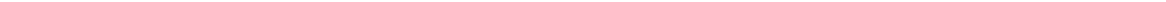
Fig. 4 Nkx2.5 expression in emu wing skeletal muscle. In situ hybridization analysis of muscle markers in the emu wing ( a ) Nkx2.5 , HH30 ( b ) Pax3 , HH30 ( c ) Stc2 , HH30 ( n = 2 at each stage). Note that expression of Nkx2.5 is restricted to the wing muscle precursors ( black arrowheads in a – c ) and latissimus dorsi ( red arrowheads ) but is not present in axial muscle precursors ( arrows in b ). d Real-time RT-PCR analysis of Nkx2.5 expression in embryonic and adult tissues demonstrating strong expression in the forelimb bud and Triceps brachii (mean ± SD). Histological sections illustrating muscle morphology in ( e , f ) Rectus femoris and ( g , h ) Triceps brachii. Inset , overview of the Rectus femoris (Rf) and Triceps brachii (Tb) at the same magni fi cation, illustrating the relative sizes of the two muscles. i Comparison of emu muscle fi ber size in leg (Rectus femoris) and wing muscle (Triceps brachii; mean area ± SD, n = 2). In situ hybridization analysis of markers in the wing primordia j Nkx2.5 , HH23 k Pax3 , HH23 l , Nkx2.5 HH20, ( m ) Pax3 HH20 ( arrowhead , prospective wing bud). Images are representative of three embryos at each stage. Statistical signi fi cance was calculated using the Student ’ s t- test. Scale bar = 1 mm ( a , j